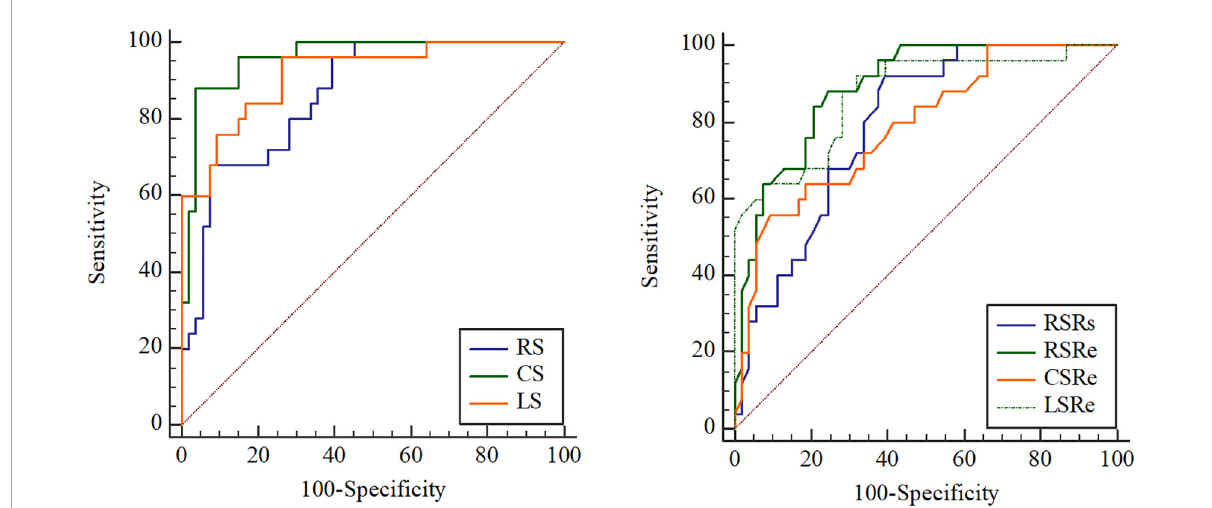
FIGURE4 Receiver operating characteristic (ROC) curve analysis of the prognostic performance of peak radial strain (RS), peak circumferential strain (CS), peak longitudinal strain (LS), peak systole radial strain rate (RSRs), peak early diastole radial strain rate (RSRe), peak circumferential strain rate at end-diastole (CSRe), and peak early diastole longitudinal strain rate (LSRe) in asymptomatic patients with repaired tetralogy of Fallot (rToF) who required pulmonary valve replacement (PVR) for moderate or severe pulmonary regurgitation.